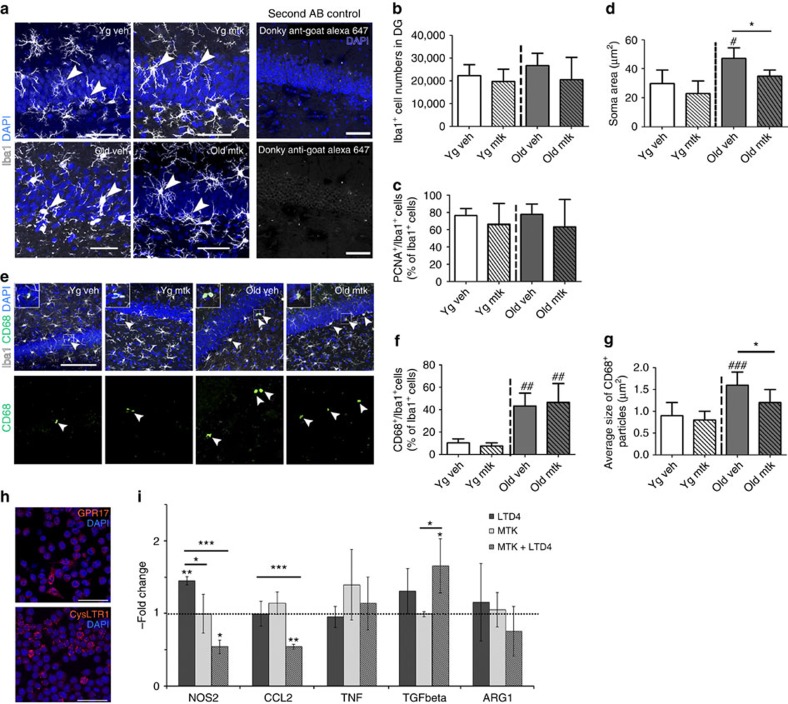
Montelukast modulates microglia in old rats and neuroinflammatory gene expression.(a) Iba1+ immunostaining in the DG of the different age- and treatment groups (white arrowheads point toward representative Iba1+ cells). Control stainings, in which the primary goat Iba1 antibody was omitted, excluded unspecific labelling of the secondary antibody. (b) Total numbers of Iba1+ cells, and (c) percentages of proliferating microglia (Iba1+/PCNA+) in the DG of young (4 months) and old (20 months) rats after a 6-week treatment with montelukast (10 mg kg−1 daily p.o.). (d) Soma sizes of Iba1+ cells in the DG of young and old montelukast- and vehicle-treated rats. (e) Representative images of CD68+ immunostaining in Iba1+ microglia (arrowheads) of the different experimental groups. (f) Percentage of Iba+ cells that contain CD68+ particles. (g) Average size of CD68+ particles in Iba1+ cells of in the DG. (h) Immunoreactivity for CysLTR1 and for GPR17 in BV-2 cells. (i) mRNA expression of NOS2, CCL2, TNF, TGF-beta1 and of ARG1 in BV-2 cells 24 h after treatment with 100 nM LTD4 and/or with 15 μM montelukast, and with vehicle control. N per group in (b–d,f,g): 10 (young vehicle), 10 (young montelukast), 7 (old vehicle), 7 (old montelukast). Every tenth section (400 μm interval) of one brain hemisphere (b,c) or four sections (d,f,g) per animal were analysed. In (i), 3–5 biological replicates were performed in technical duplicates. Data are shown as mean±s.d. *P<0.05, **P<0.01, ***P<0.001. Significant differences between the old age groups and the young vehicle group were indicated by # (#=P<0.05; ###=P<0.001). One-way ANOVA (b–d,f,g) and Two-way ANOVA (i) with Bonferroni post hoc tests were performed. Scale bars, 50 μm (a); 100 μm (e). yg veh, young vehicle; yg mtk, young montelukast; old veh, old vehicle; old mtk, old montelukast; DG, dentate gyrus.